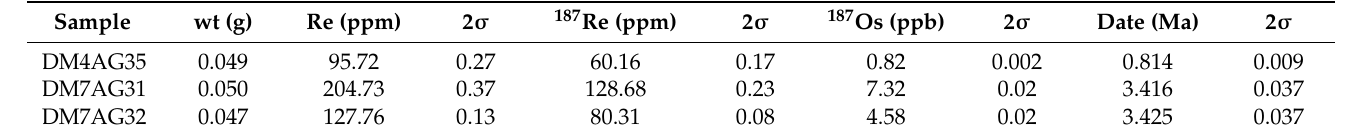
Table 4. Re-Os data for Don Manuel